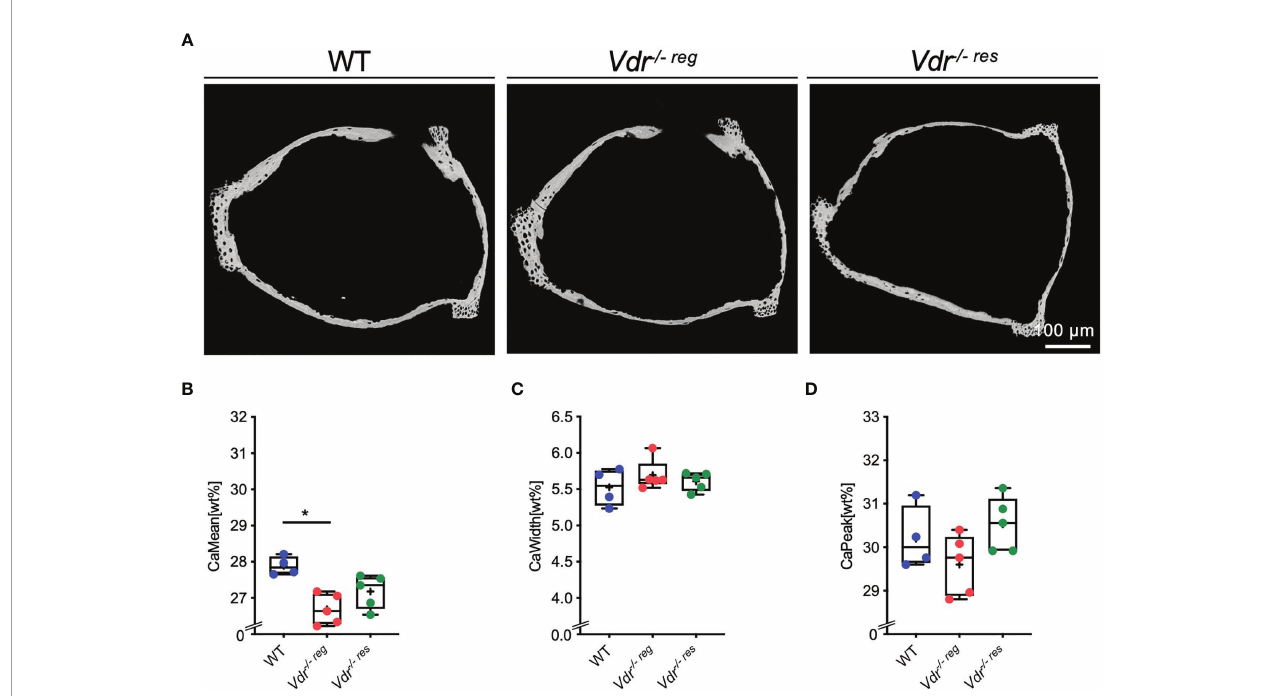
FIGURE 2 | BMDD characteristics of the stapes analyzed by qBEI. (A) Representative images of qBEI analysis of the stapes in WT, Vdr -/- reg and Vdr -/- res mice. Mineralization characteristics were evaluated by analyzing the (B) mean calcium content (CaMean), (C) mineralization heterogeneity (CaWidth) and (D) peak of the calcium distribution (CaPeak). ANOVA and repeated measures with Holm-Sidak correction was performed in panels (B – D) .